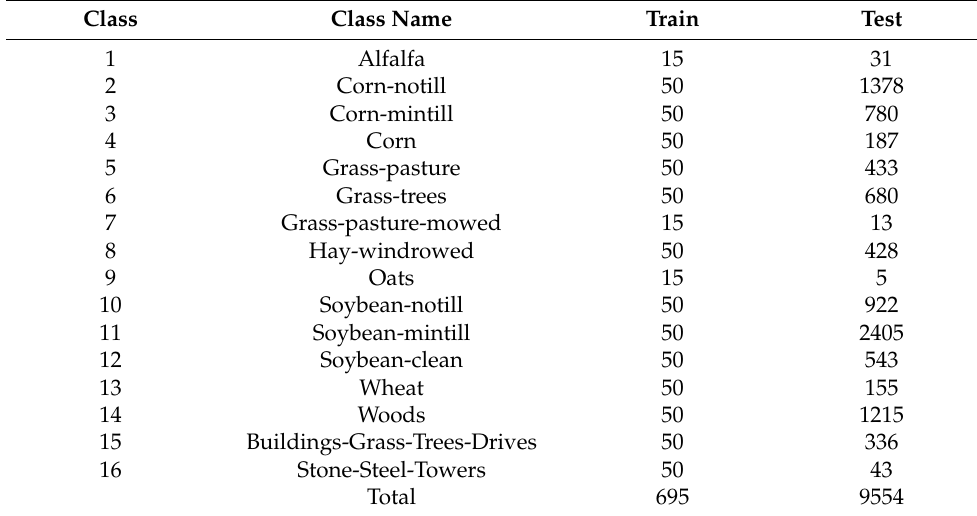
( b ) Figure 6. Pavia University Data Set (( a ) False-color map; ( b ) Ground-truth map).